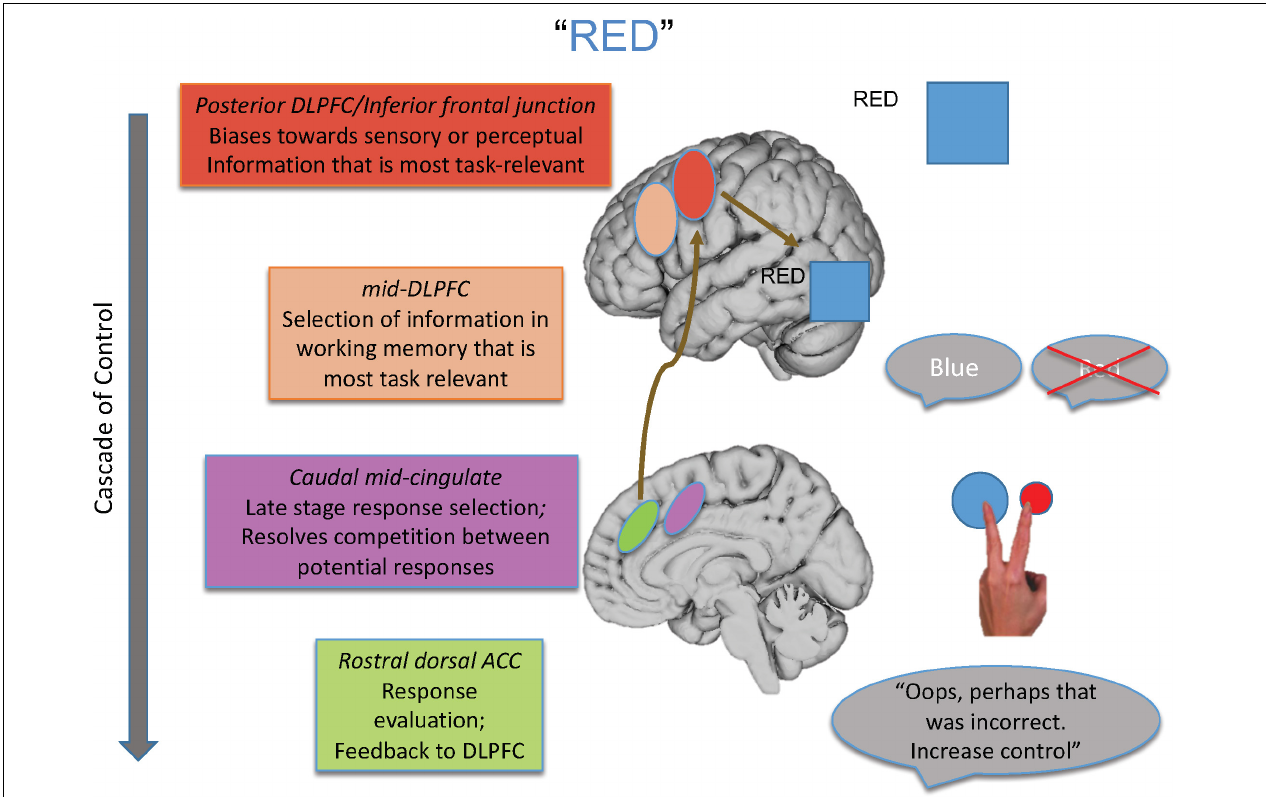
FIGURE 1 | Shown here is the cascade-of-control model outlining the brain regions that are involved in controlling interference in the Stroop task. For an incongruent trial, such as the word “red” in blue ink, control is implemented via a cascade. First posterior regions of DLPFC bias toward task-relevant information relative to task-irrelevant information, as shown by the larger representation of the color blue than the word red. Next mid-DLPFC regions bias toward the relevant information to be maintained in working memory, here biasing toward maintaining the representation of blue and not red. At the next point in the cascade, posterior portions of ACC bias toward the response linked to blue and not toward that linked to red, depicted by the larger blue circle. Finally, more rostral regions of ACC are involved in response evaluation and sending information to DLPFC to adjust control. Importantly, the degree to which one region is active in controlling Stroop interference depends on how well control has been implemented at prior points in the